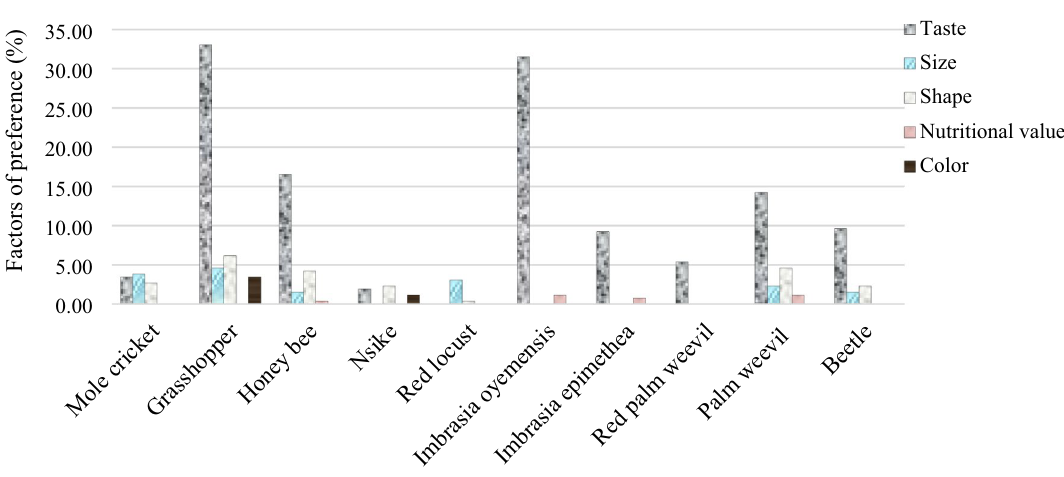
Figure 4. Preference of edible insects represented in two Territories. Respondents gave reasons for preferring one edible insect over another. The preference was based on taste, size, shape, nutritional value and colour. (Figures plotted using Microsoft Excel for Mac 16.56 https:// www. micro soft.